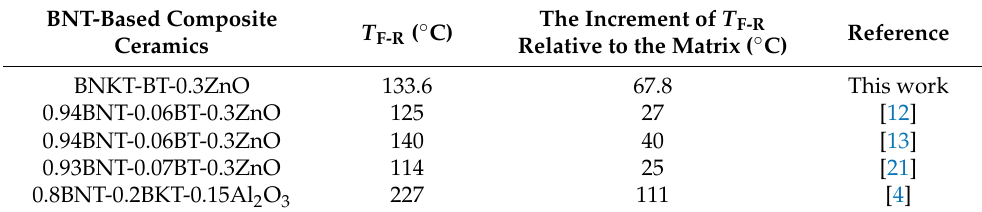
Figure 3. The temperature dependent relative dielectric constant ε r and loss spectra tan δ of BNKT- BT- x ZnO composites: ( a ) x = 0, ( b ) x = 0.1, ( c ) x = 0.2, ( d ) x = 0.3. Table 1. The comparison of T F-R in different BNT-based composite